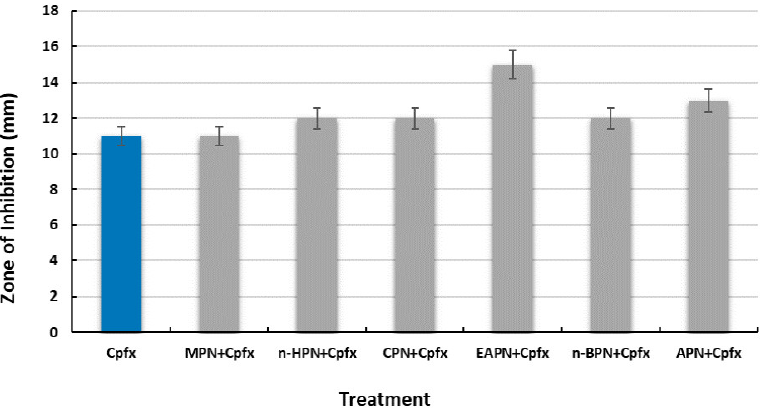
Figure 6. Antibiotic reversal activity of P. nigrum extracts in combination with ciprofloxacin (5 μg) for S. aureus